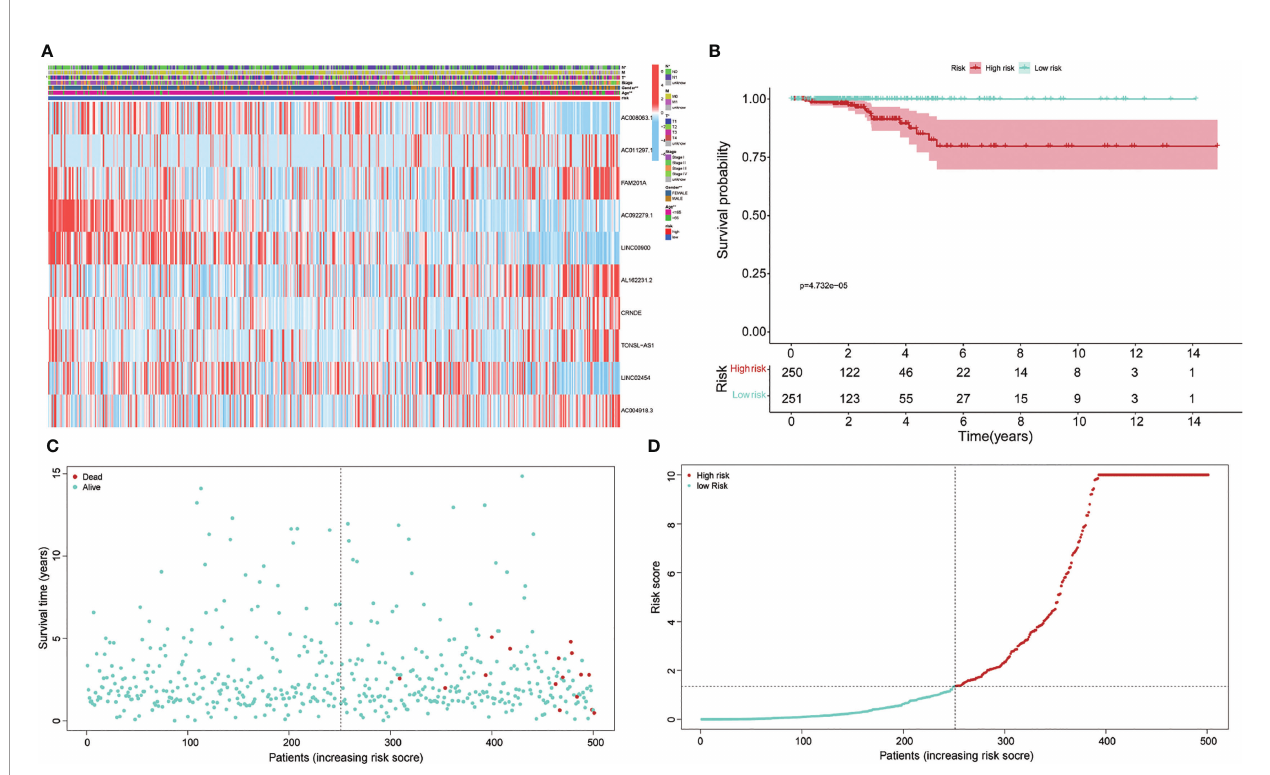
FIGURE 2 | Prognosis and expression of risk genes in the two groups of papillary thyroid carcinoma (PTC) patients. (A) The heatmap displayed the expression levels of autophagy-related long noncoding RNAs (lncRNAs) in the high-risk and low-risk groups. (B) Kaplan – Meier survival analysis of the high-risk and low-risk groups based on the risk strati fi cation. (C) The scatter plot based on the survival status of each patient. The different colors matched the status of survival and death. (D) The risk curve was drawn based on the risk score of each sample. The different colors matched the status of